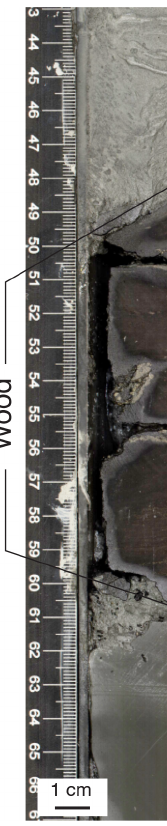
Figure 2. Section of Core 362-U1480G-11R, including the largest of the wood fragments. The image is lightened to highlight these